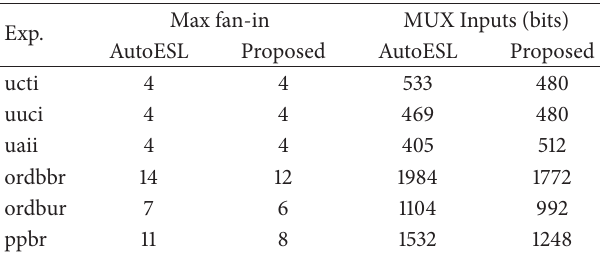
Table 4: Maximum fan-in and number of multiplexers given by AutoESL and the proposed. Exp.